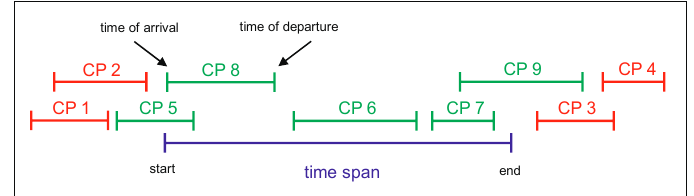
Figure 7. Generic examples of charging processes, which can be shifted in or within the time span in green and those, which cannot in red.